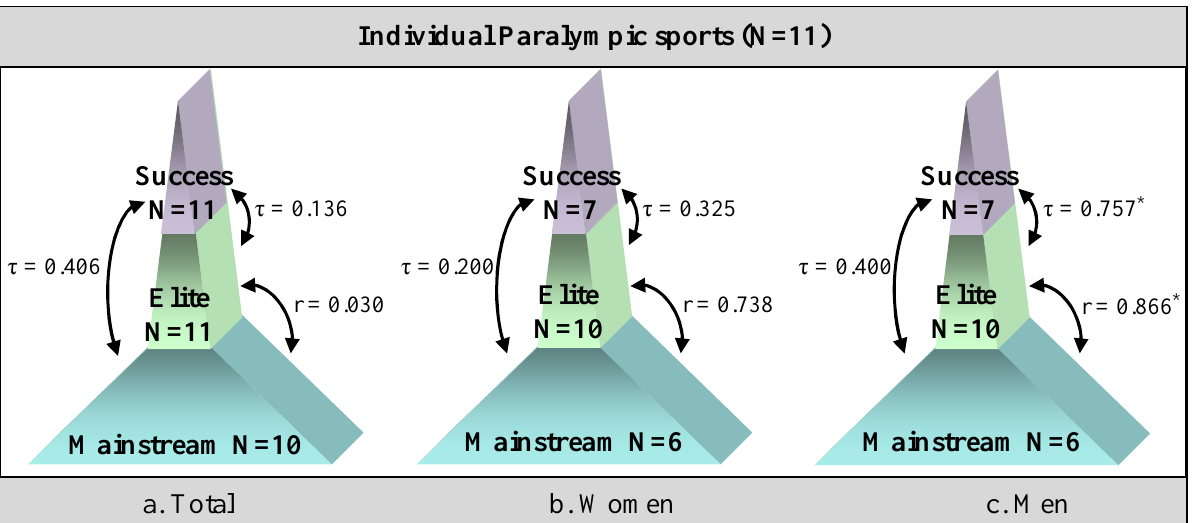
Figure 2. Correlations between mainstream- and elite participation rates and relative Paralympic success in the 11 individual sports. N is the sample size and * indicates p < 0.05. a. Relationships in all individual Paralympic sports. b. Relationships for females in the individual Paralympic sports. c. Relationships for males in the individual Paralympic